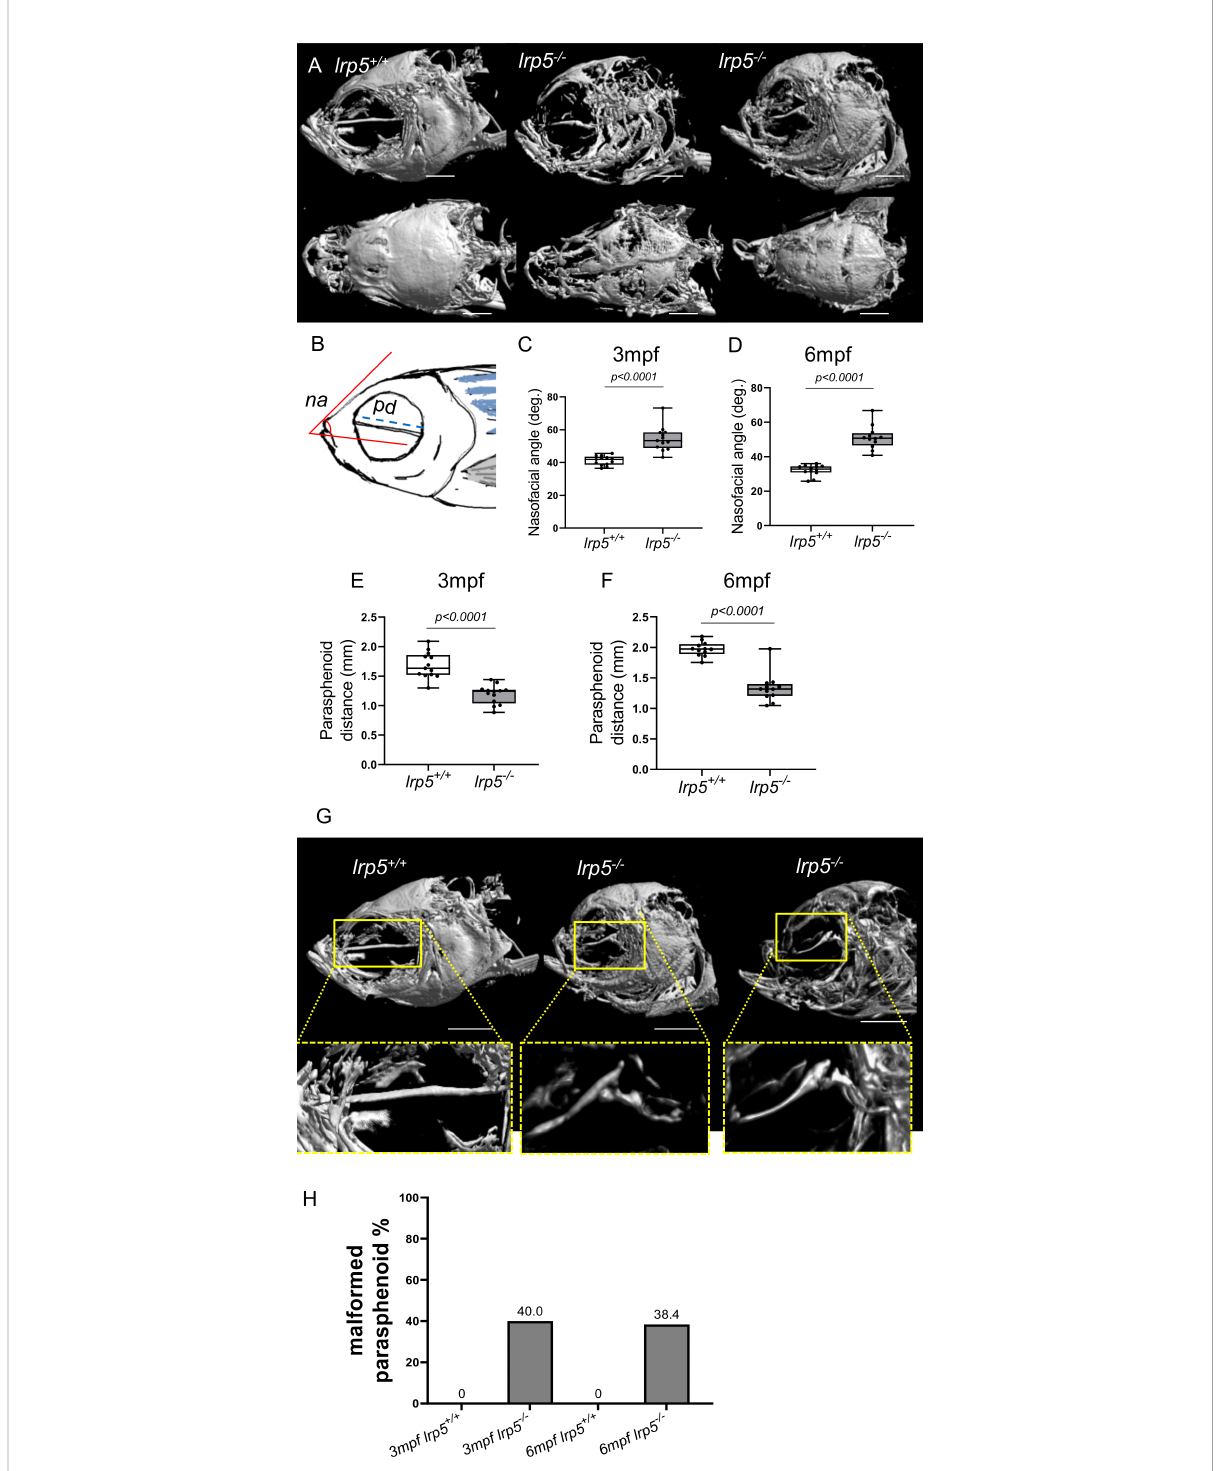
FIGURE 3 Craniofacial deformities of adult lrp5 mutant. (A) Adult lrp5 -/- display major deformities of neuro- and viscera- craniums. (B) Schematic representation of morphometrical parameters measured na- nasofacial angle, pd- parasphenoid distance between its edges. (C, D) Nasofacial angle at 3mpf and 6mpf is signi fi cantly bigger in lrp5 -/- compared to lrp5 +/+ , meanwhile parasphenoid distance is signi fi cantly shorter in lrp5 -/- adult fi sh at 3 and 6mpf (E, F) . (G) Parasphenoid bones of lrp5 -/- are severely deformed and display a similar fracture pattern, outlined in yellow. (H) 40% of lrp5 -/- fi sh displayed malformed parasphenoid at 3mpf and 38.4% at 6mpf within lrp5 -/- group. At 3mpf and 6mpf lrp5 +/+ display no indication of parasphenoid deformities.(Scale bar 500µm, 3mpf n =13-15 fi sh, 6mpf n =12-13 fi sh,